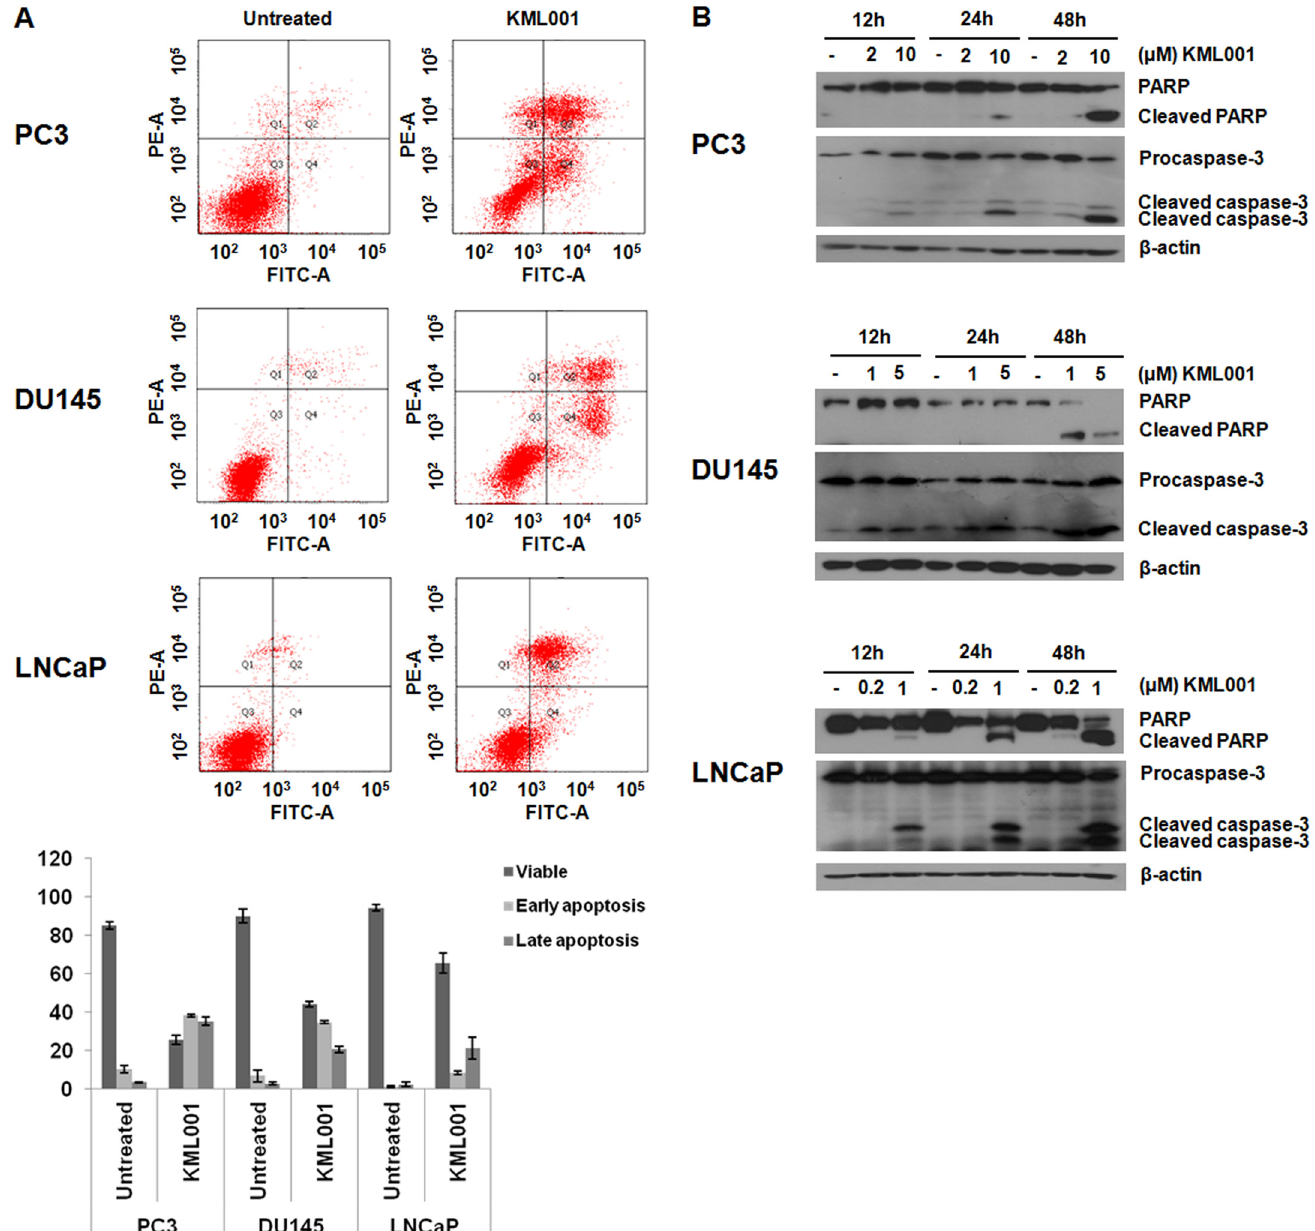
Fig 3. Induction of apoptosis by KML001 in prostate cancer cells. (A) FACS analysis of annexin V/PI staining. Results show early apoptosis, defined as annexin V-positive and PI-negative cells, and late apoptosis, defined as annexin V-positive and PI-positive cells. Results were expressed as means ± SD of three independent experiments. (B) Western blot analysis of the time- and dose-dependent cleavage of PARP and activation of procaspase-3.